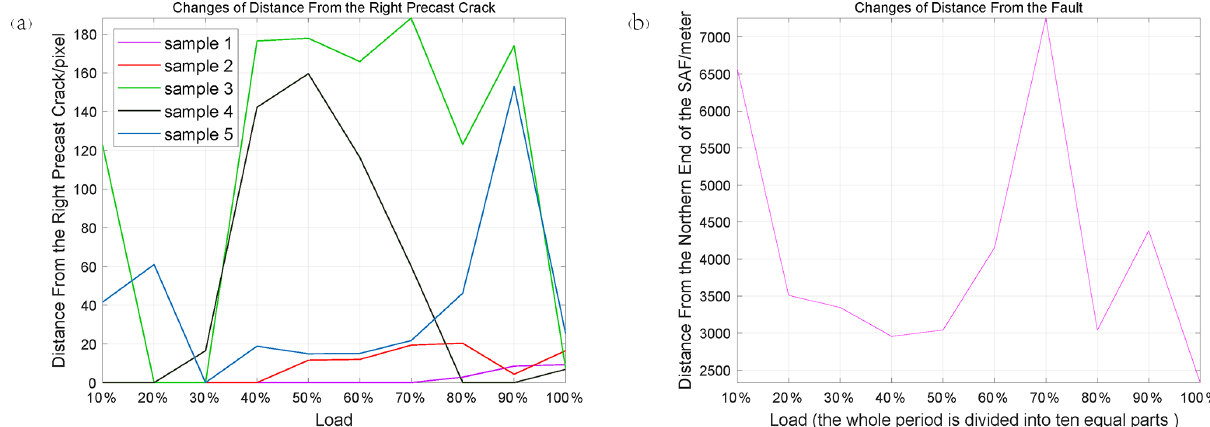
Figure 8. Changes in distance. (a) The average distance between the positions of the sampling points with large differential maximum principal strain and the right precast crack. The colored lines represent the results of different samples. (b) The average distance between the small earthquakes (magnitude < 5) and the northern end of the SAF in the research